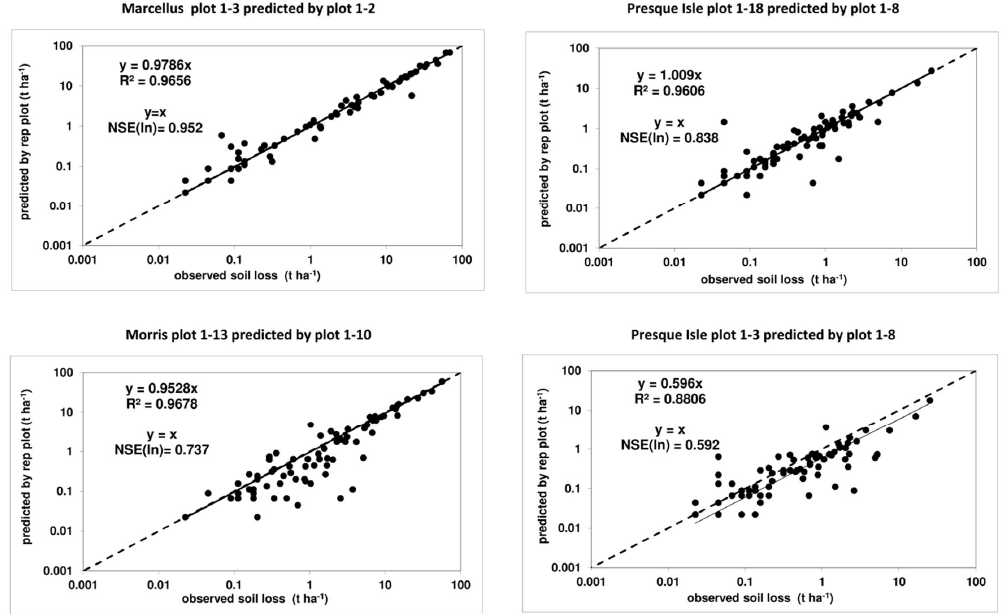
Figure 14. Predictions of observed event soil losses on some bare fallow plots from observed soil losses from a replicate at three locations in the USA (source: Kinnell [63]).